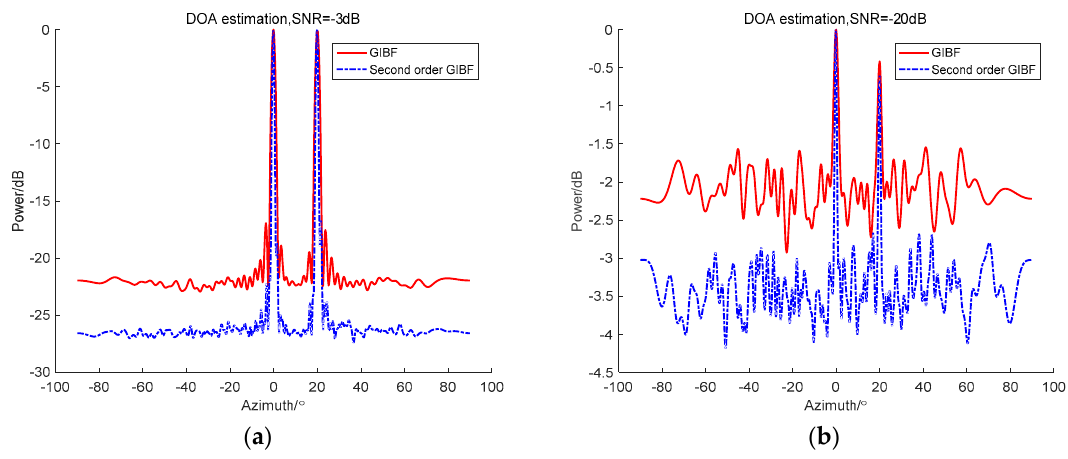
Figure 6. Comparison between GIBF and second order GIBF under different SNRs: ( a ) − 3 dB ( b ) − 20 dB.